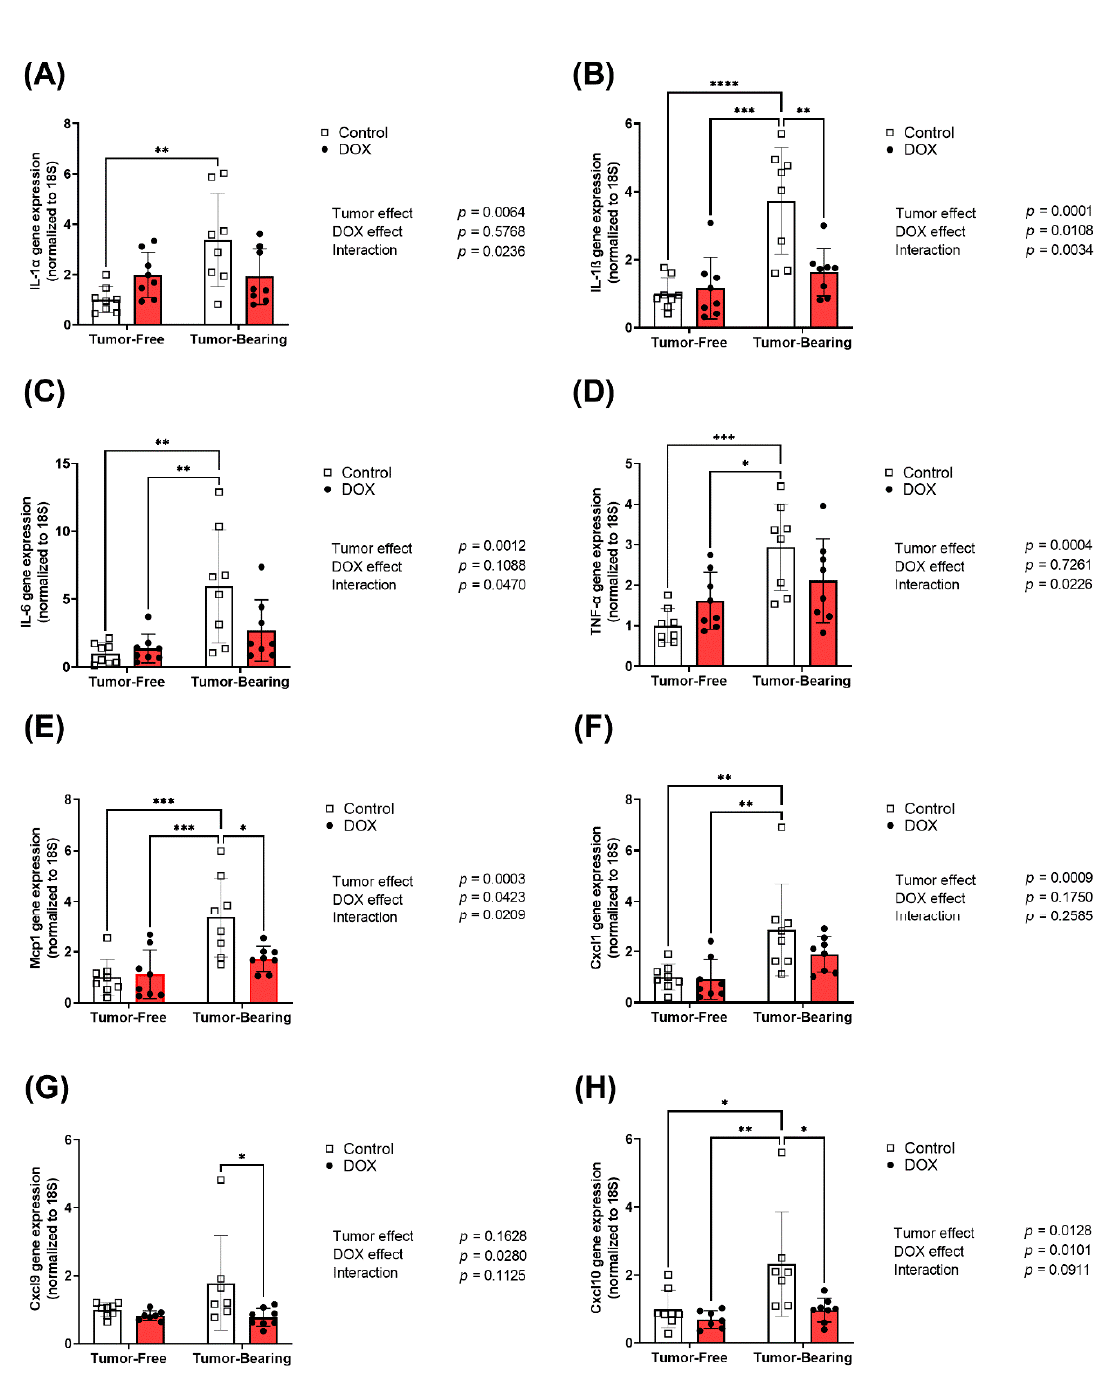
Figure 3. Chronic administration of DOX (4 mg/kg/week) for 3 weeks abrogates tumor-induced upregulation of inflammatory markers in the heart. Hearts were harvested from both tumor-free and EL4 lymphoma tumor-bearing juvenile C57BL/6N mice one week following the administration of 4 mg/kg/week of DOX or equivalent volume of sterile saline for 3 weeks ( n = 7–8 per group). Following the extraction of total RNA, cardiac mRNA expression of ( A ) IL-1 α , ( B ) IL-1 β , ( C ) IL-6, ( D ) TNF- α , ( E ) Mcp-1, ( F ) Cxcl1, ( G ) Cxcl9, and ( H ) Cxcl10 were determined by real-time PCR. Values were normalized to 18S rRNA and expressed relative to saline-treated tumor-free mice. Values are shown as means ± SEM. Two-way ANOVA table demonstrates DOX, tumor, and interaction effects on the mRNA expression. Statistical significance of pairwise comparisons was determined using two-way ANOVA with Tukey’s post hoc analysis (* p < 0.05, ** p < 0.01, *** p < 0.001, and **** p < 0.0001).